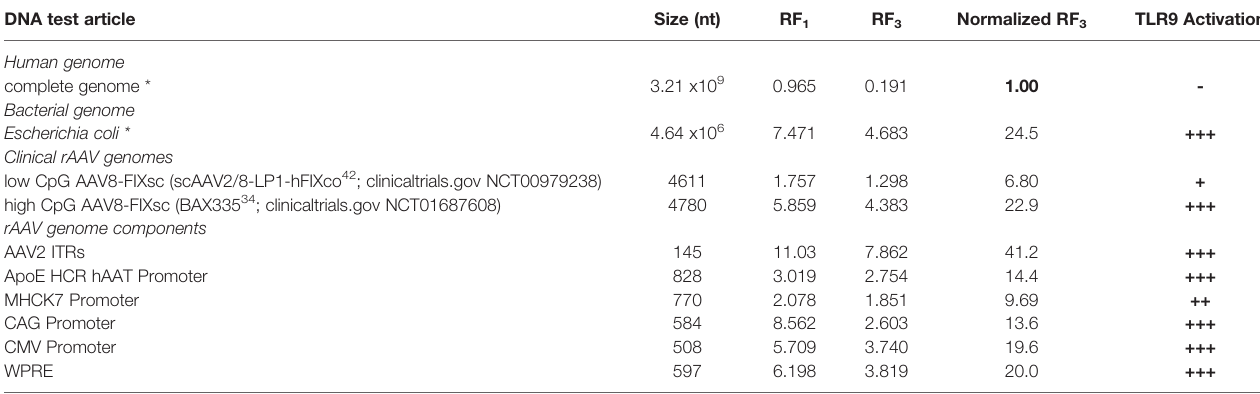
TABLE 1 | TLR9 Activation Potential and Risk Factor (RF)* calculations for AAV genomes and components. DNA test article